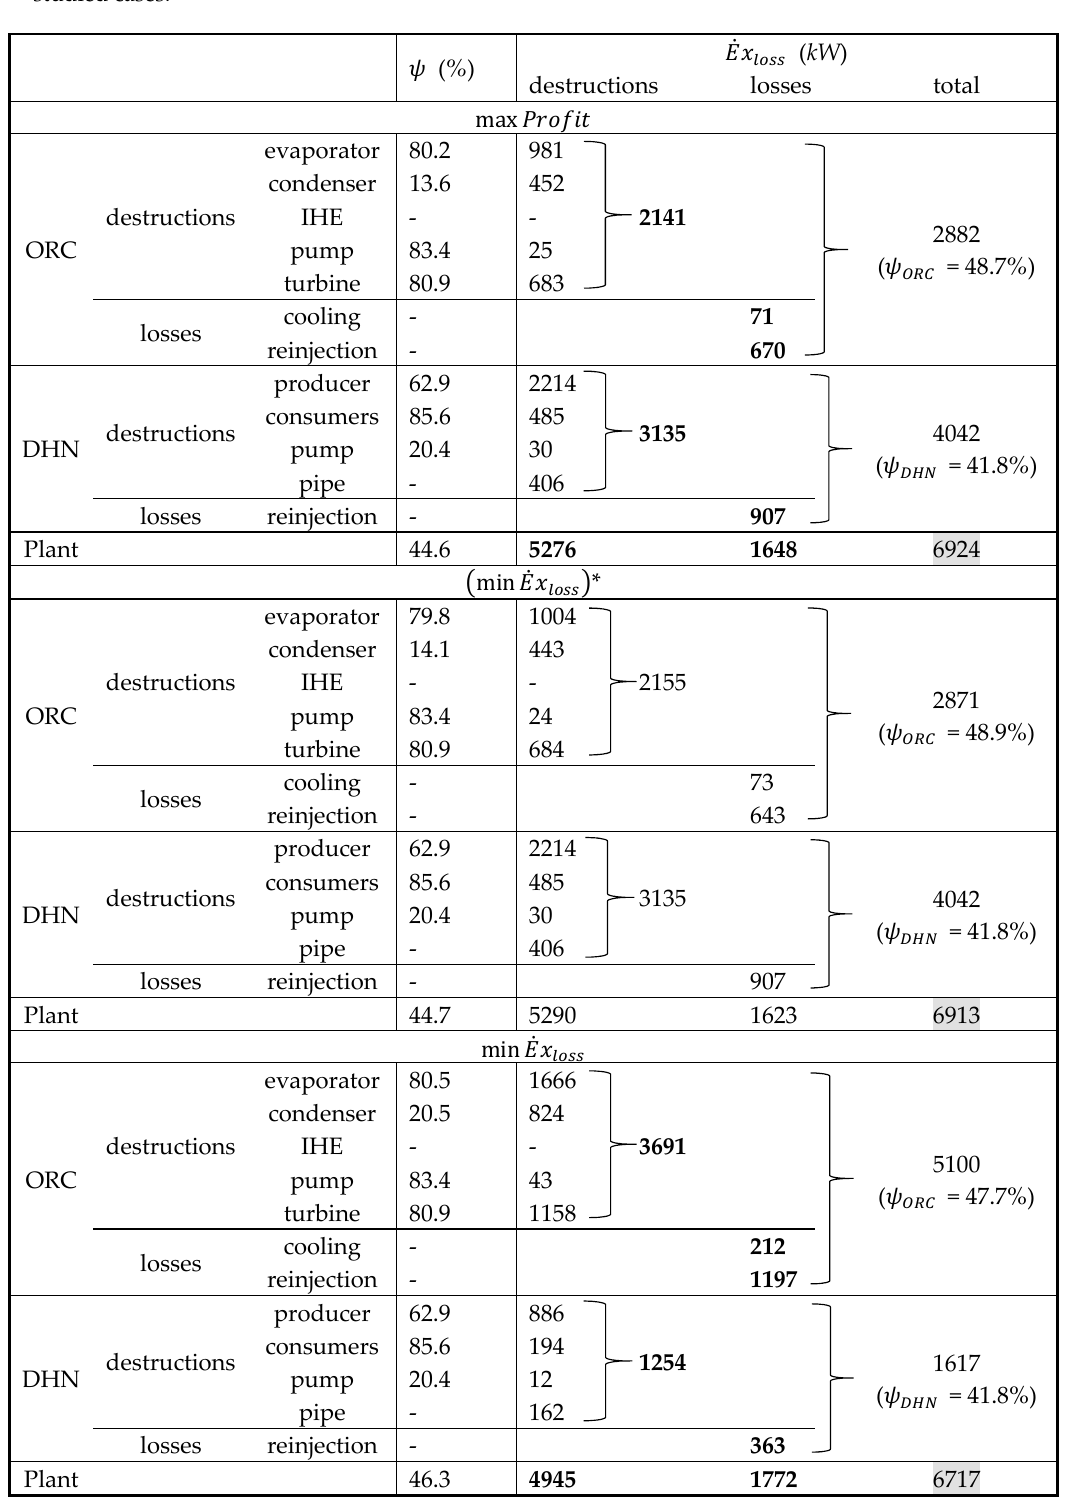
. . Ex loss . Highlighted values: Ex loss value for the